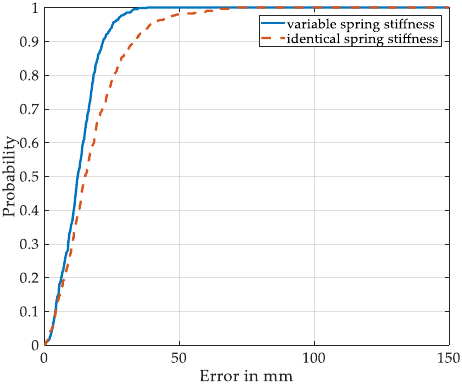
Figure 11. Cumulative distribution function, CDF, of spring-relaxation localization error. The red line corresponds to no weighting (uniform springs) being used. The blue line corresponds to weighting (variable stiffness springs) being